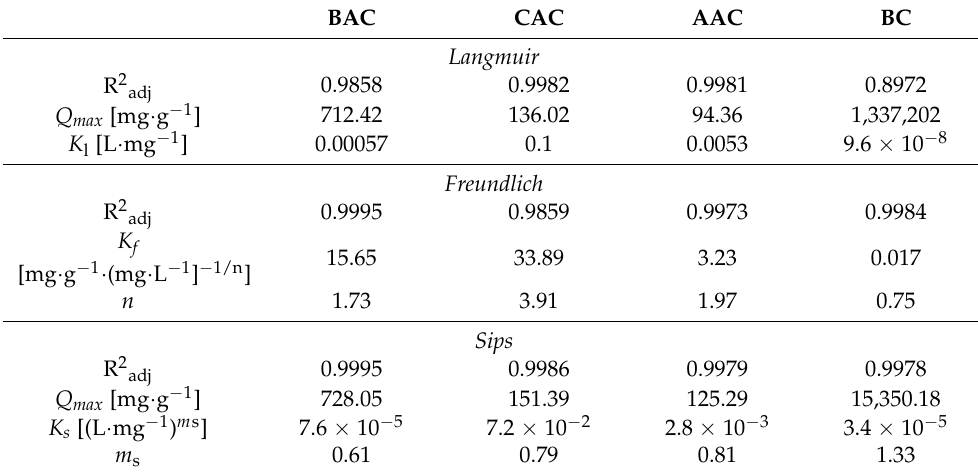
Table 5. Parameters of adsorption isotherm models used in this study and respective determination coefficients for the four adsorbents. BAC CAC AAC BC Langmuir R 2 adj 0.9858 0.9982 0.9981 0.8972 Q max [mg · g − 1 ] 712.42 136.02